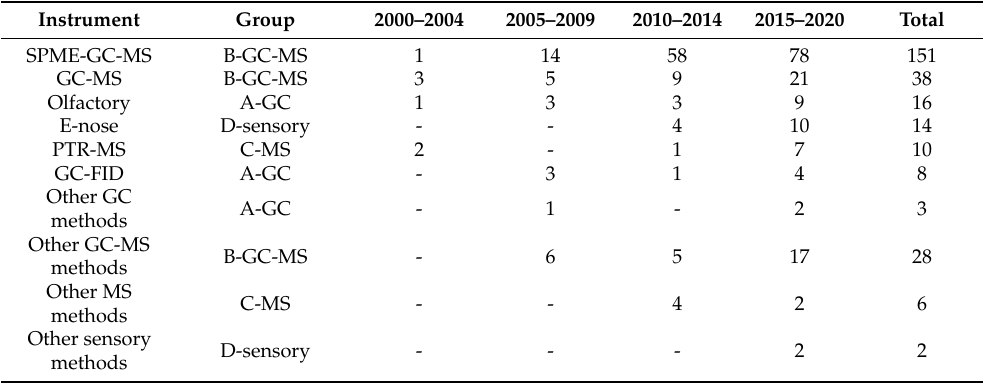
Table 7. Evolution of the use of different methodologies/instruments in research on meat VOC profiles from 2000–2020 and their classification